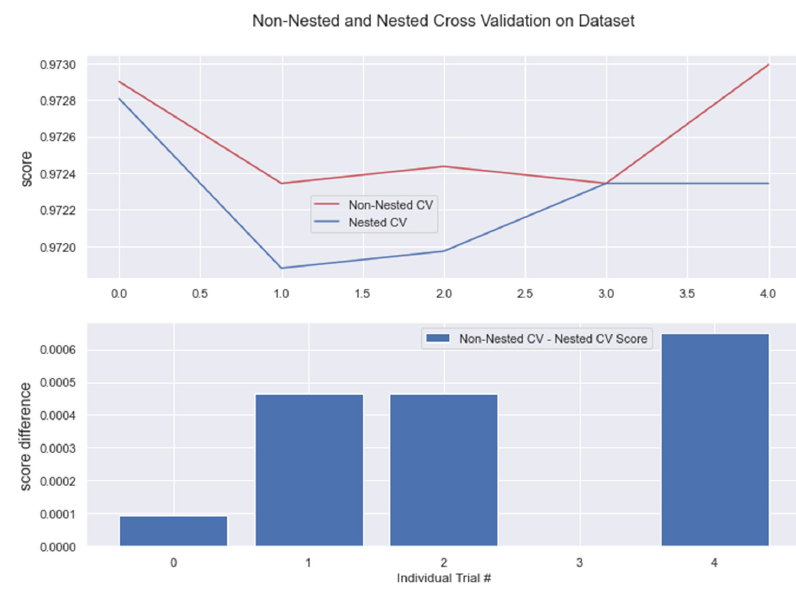
Figure 17. Non-Nested and Nested cross-validation on LR algorithm.